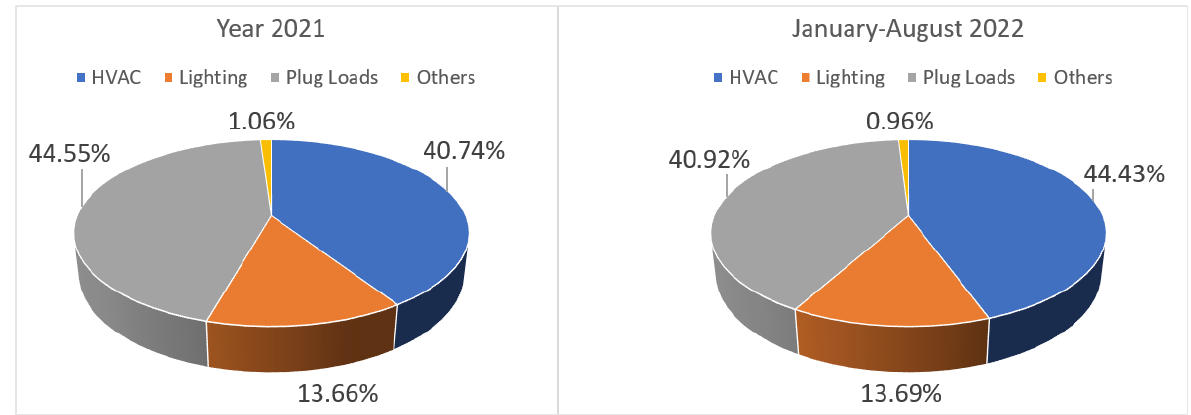
Figure 1. 2021 and 2022 electricity consumption per usage in the HARC building .